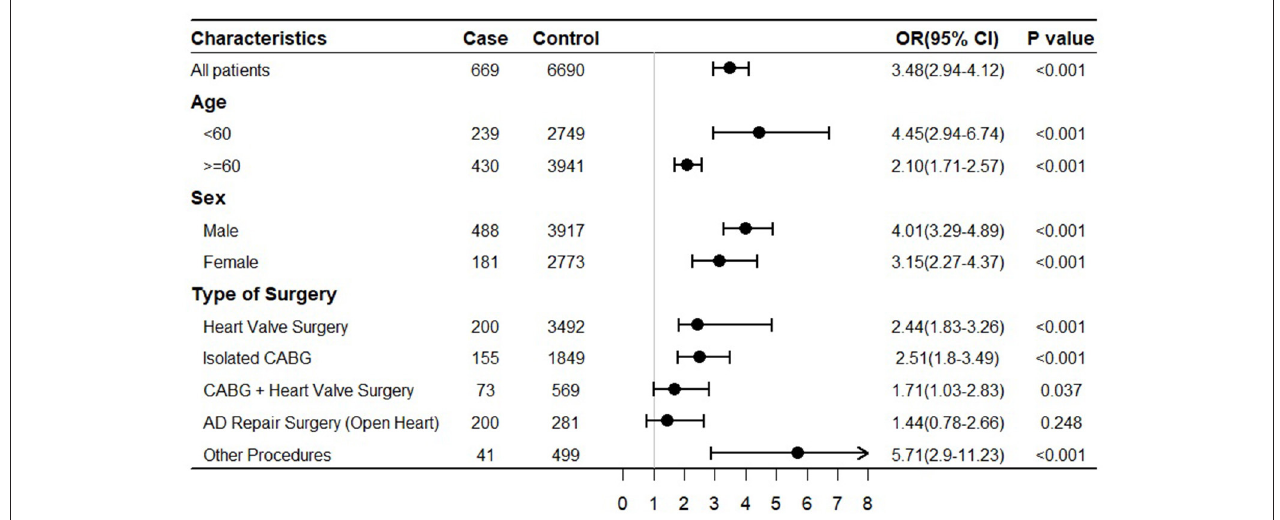
FIGURE 2 | Subgroup analysis for delirium after cardiac surgery.